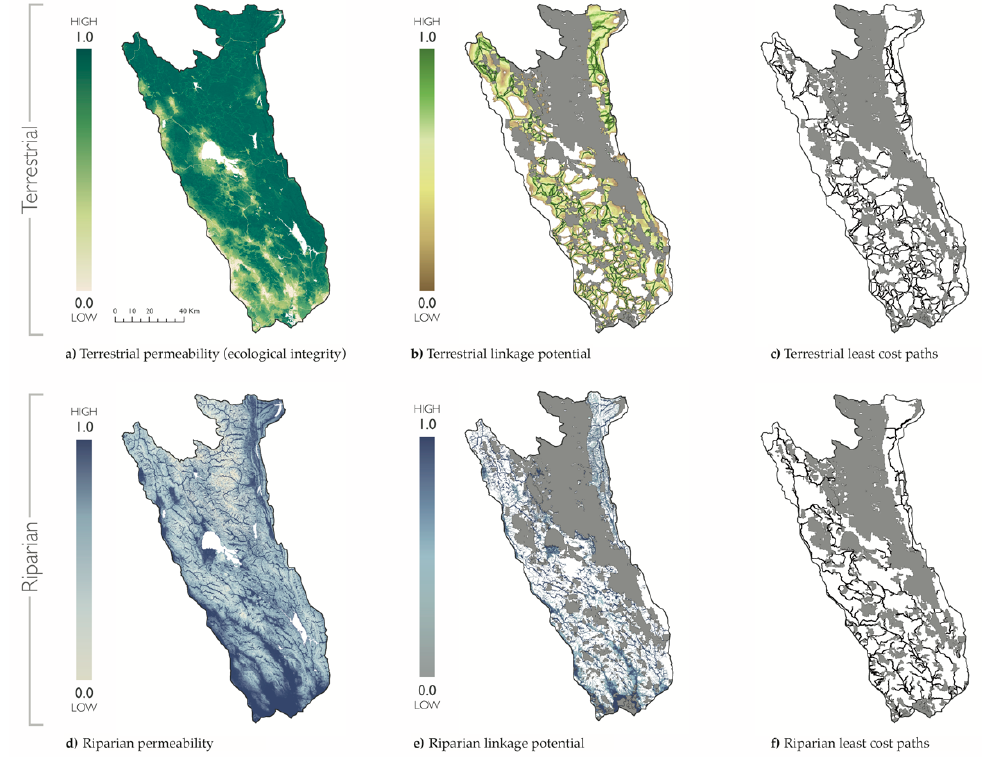
Figure 2. Terrestrial and riparian connectivity. Maps of the Mayacamas to Berryessa study region and protected areas (gray) overlaid with terrestrial ( a – c ) and riparian ( d – f ) connectivity data for permeability (i.e., the inverse of resistance used to map linkages) ( a , d ); linkage potential ( b , e ); and least cost paths ( c , f ).